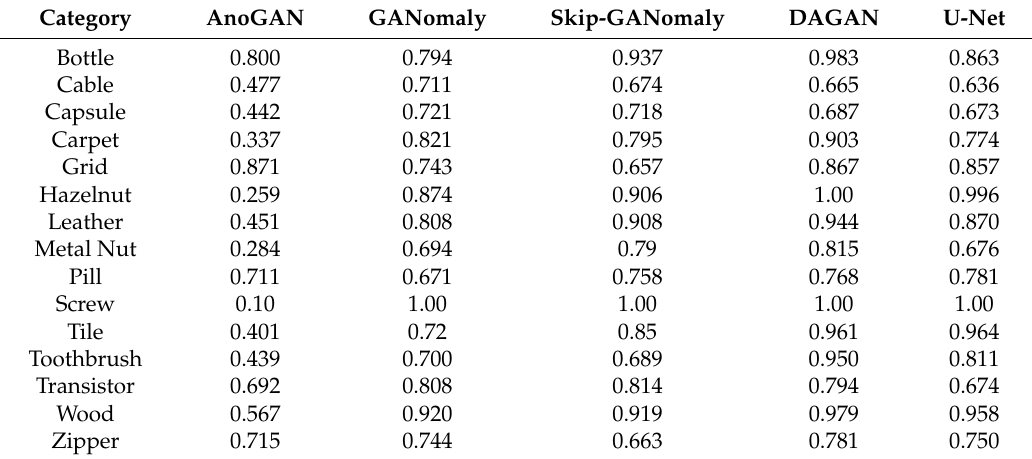
Table 2. AUCs of each category in MVTec AD dataset using AnoGAN, GANomaly, Skip-GANomaly, proposed method (DAGAN), and U-Net